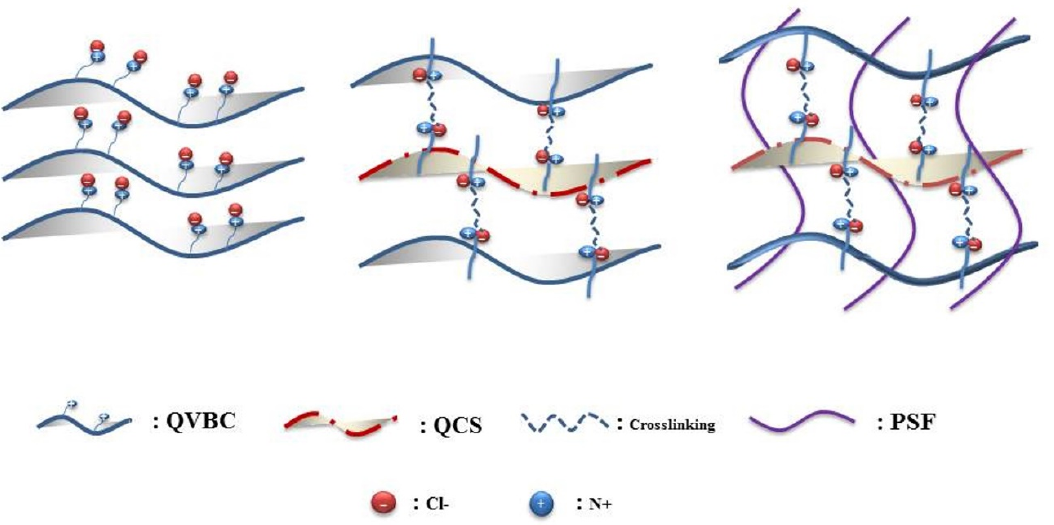
Figure 1. Schematics of membrane fabrication.